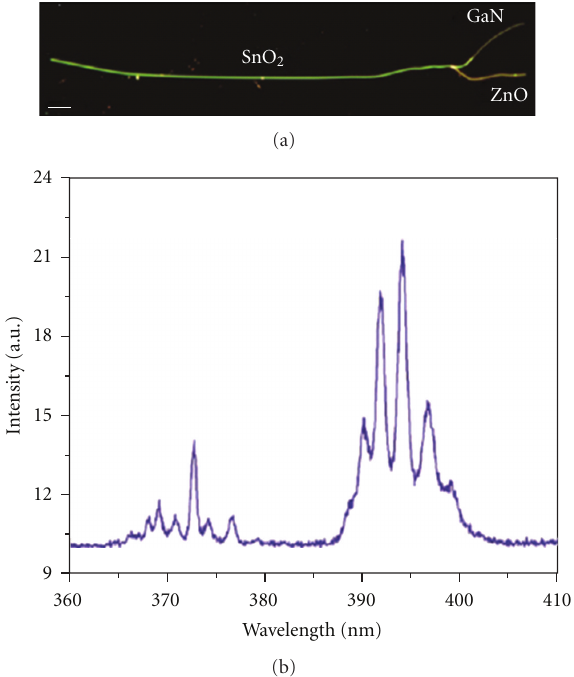
Figure 11: (a) Dark-field image illustrating the coupling of two nanowire lasers (GaN and ZnO) to a common SnO 2 nanoribbon waveguide. Scale bar = 25 μ m. (b) Spectra recorded at the left terminus of the SnO 2 nanoribbon after simultaneous nanowire laser